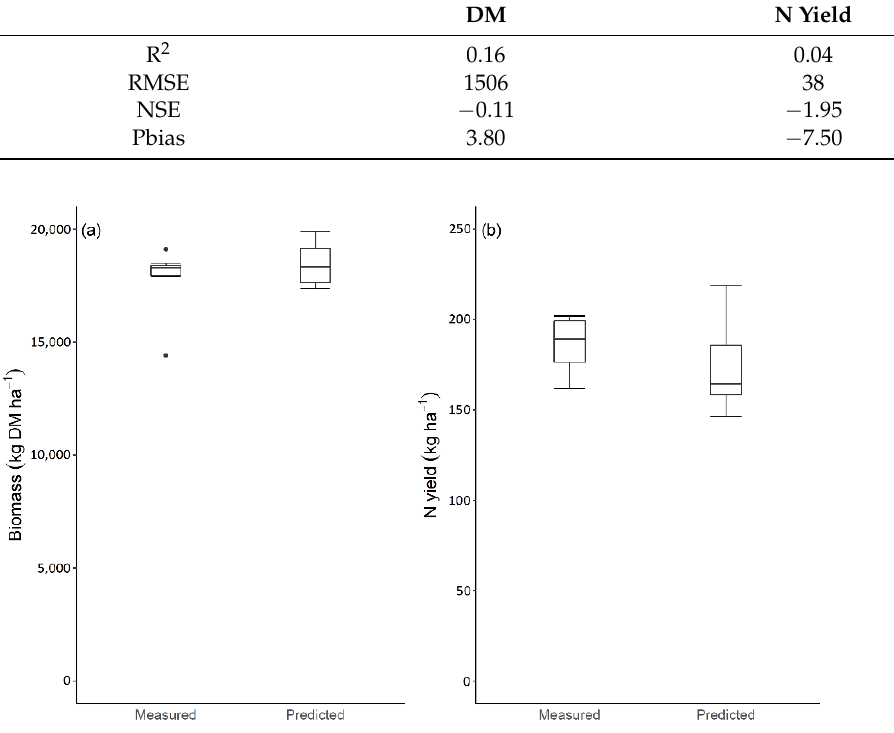
Table 3. Model performance statistics for dry matter (DM) and N yields of forage maize at experimen- tal site 1 ( n = 7); RMSE = root mean squared error (kg ha − 1 year − 1 ), NSE = Nash Sutcliffe efficiency score ( − ), and Pbias = percent bias (%).